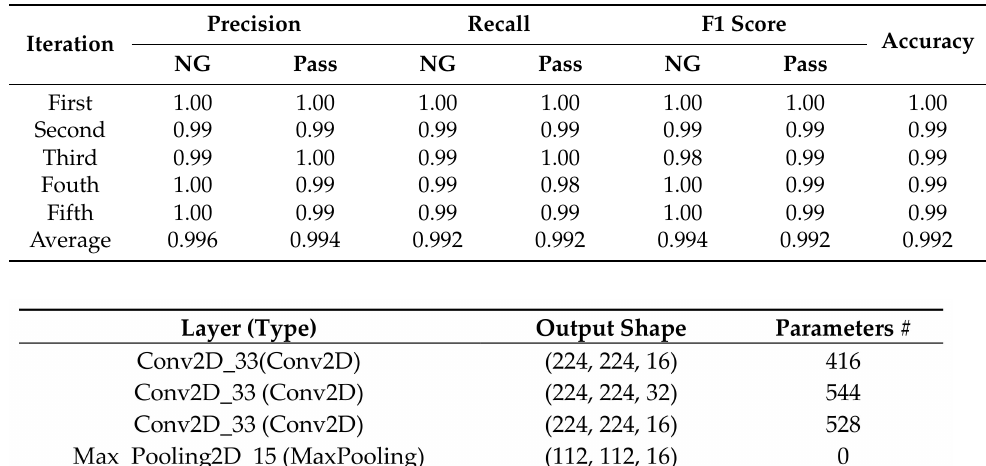
Table A6. LeNet with K-fold + (1 × 1) Convolution + GAP Iterations.